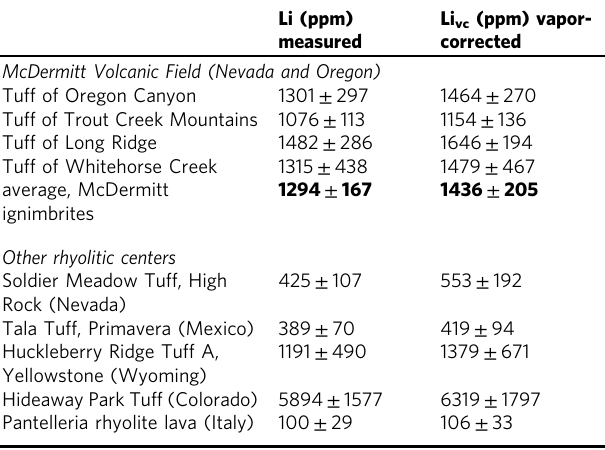
Data reported as average concentration of all melt inclusions analyzed from each sample ± one standard deviation. Bold values represent the average Li concentration and standard deviation for all ignimbrites from McDermitt Volcanic Field Unit information listed in Supplementary Table